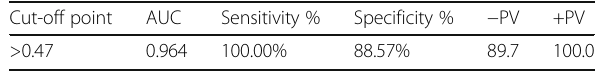
Table 4 The sensitivity and specificity for S100A14 Cut-off point